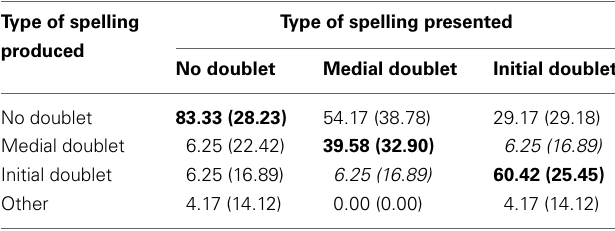
Table 2 | Percentage of different types of spellings produced in Experiment